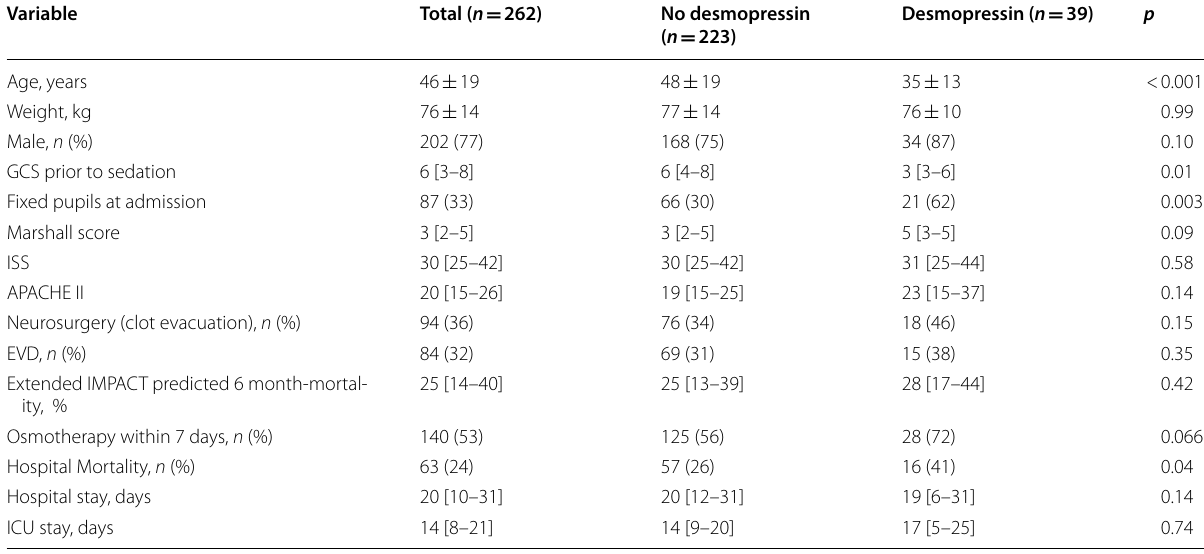
Data are reported as mean EVD extraventricular drain, GCS Glasgow Coma Scale, ISS injury severity score, APACHE acute physiology and chronic health evaluation